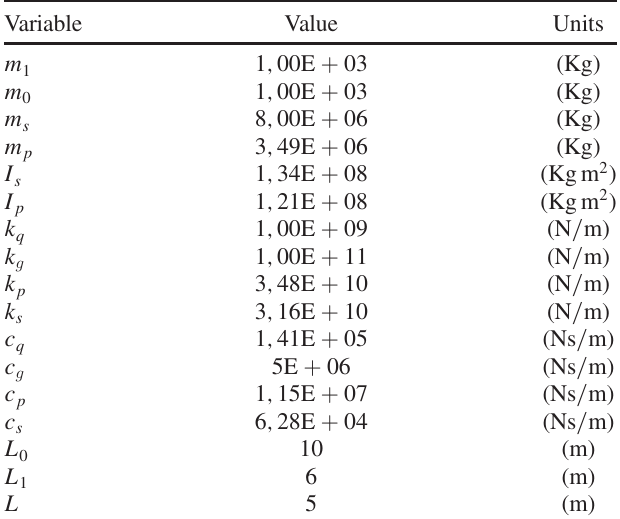
ffiffiffiffiffiffiffiffiffiffiffiffiffiffiffiffiffiffiffiffiffiffiffi FIG. 4. Real part of the correlation between the ground motions at the support locations. FIG. 5. Imaginary part of the correlation between the ground motions at the support